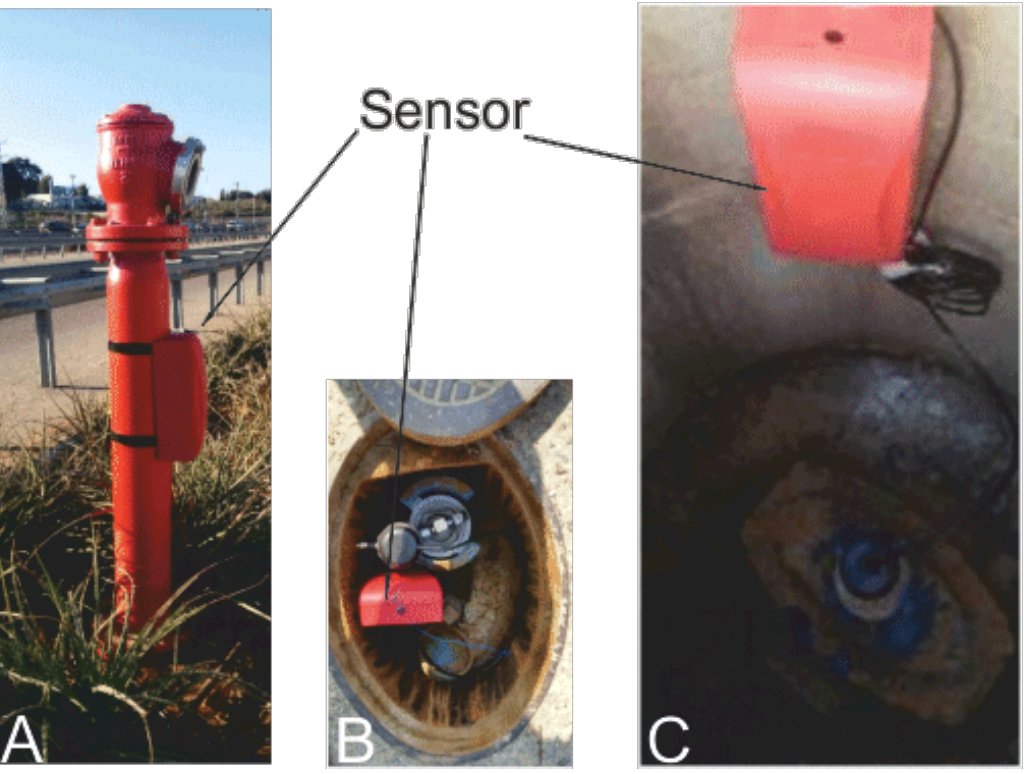
Figure 2: Methods of installing a stationary sensor: (A) on an above-ground hydrant, (B) on an underground hydrant, (C) in the gate valve chamber